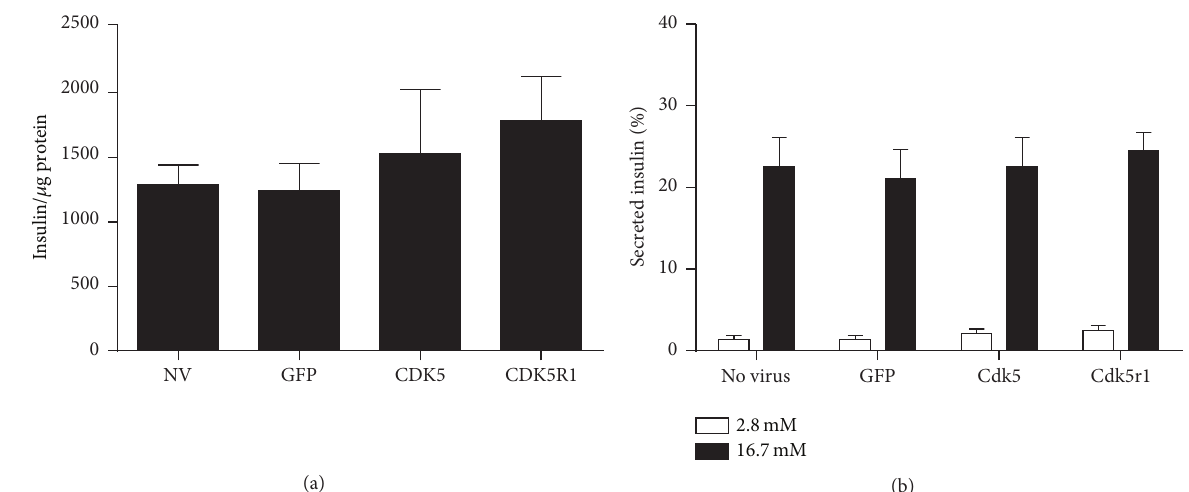
Figure 6: Overexpression of Cdk5r1 maintains glucose stimulated insulin secretion. (a) Total insulin content was measured in primary rat islets at 96 hours after transduction with AdCMV-GFP, AdCMV-Cdk5, or AdCMV-Cdk5r1. No significant difference was observed in total insulin content. (b) Glucose stimulated insulin secretion was measured 96 hours after transduction with AdCMV-GFP, AdCMV-Cdk5, or AdCMV-Cdk5r1 in media containing 2.5 mM glucose and 16.7 mM glucose for 1 hour. No decrease in glucose stimulated insulin rate was observed. Data represent the mean ± SEM of four independent